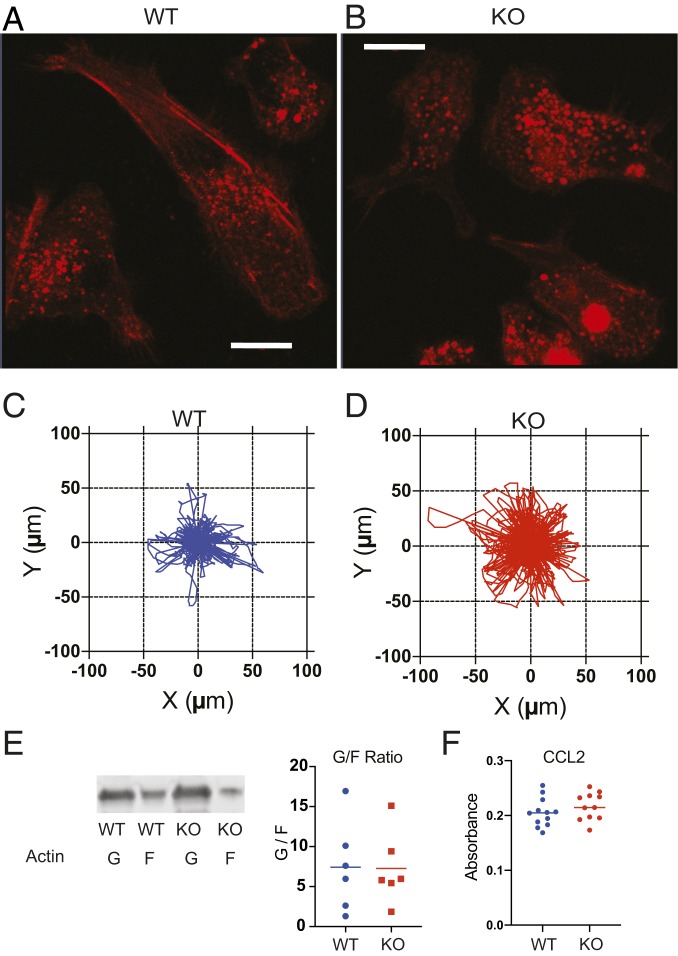
BMAL1 deletion alters macrophage morphology and motility. (A and B) Peritoneal macrophages from LysM-Bmal1−/− and floxed littermate controls. Live cell imaging with ultraresolution confocal microscopy, using Airyscan detector showing F-actin. (Scale bar, 10 µm.) (C and D) Macrophages were also tracked through spontaneous migration for 4 h using a Livecyte kinetic cytometer (phasefocus). The distance moved and direction are represented in the rose plots. Mean step length WT 3.81 µm, and KO 5.04 µm; median step length WT 2.24 µm, and KO 3.61 µm; unpaired t test, P value < 0.0001 (cell number WT n = 683, KO n = 870 combination of cells from 12 wells per genotype). (E) Macrophages (WT and KO) were cultured for 72 h postrecovery from animals before lysis and analysis of globular and filamentous actin. The different molecular forms were quantified by immunoblot and plotted. There was no genotype effect. (F) Transwell migration assay. Peritoneal macrophages were cultured in vitro at 1 × 105 cells per 24-well plate in a Transwell insert. Migration across the membrane toward CCL2 at 500 ng/µL was quantified using crystal violet staining after 4 h (Mann–Whitney U test; NS P > 0.05).